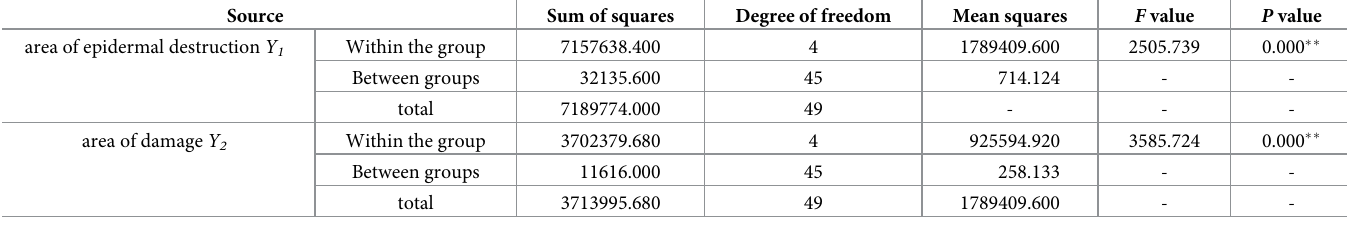
Table 4. Variance analysis of the influence of sweet potato falling height on various indexes.